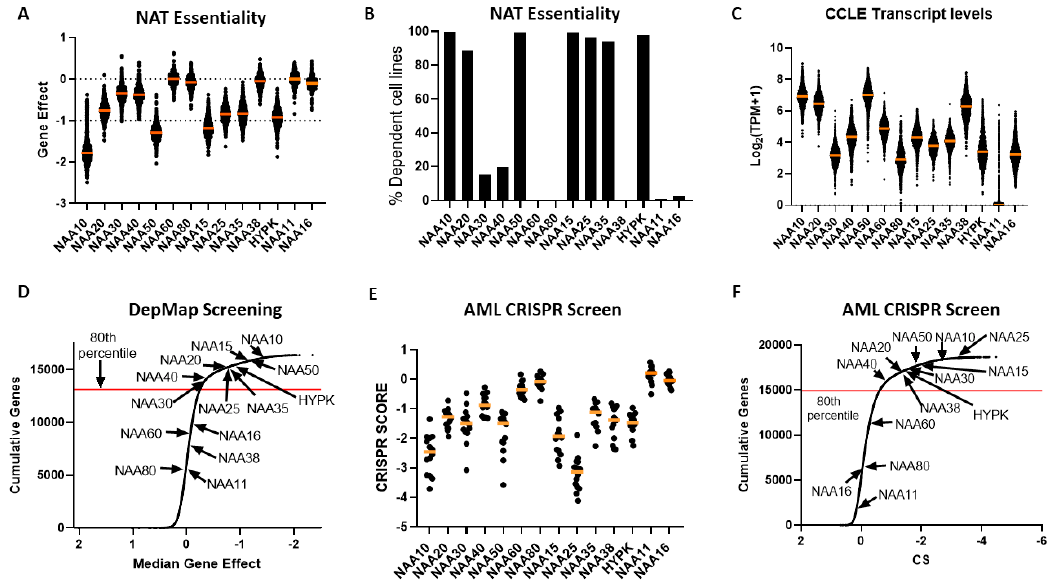
Figure 4. Dependency of cancer cells on functional NAT complexes. ( A ) Gene effect (CEREC) of CRISPR-CAS KO of human NAT catalytic and auxiliary genes across 739 cell lines. More negative values indicate greater sensitivity to KO. Each cell line is represented by a circle symbol, and the median gene effect across all cell lines is depicted by an orange line; ( B ) Percentage of cell lines with CRISPR-CAS KO data which were deemed as dependent on NAT gene, as calculated in DepMap database; ( C ) Transcript levels for NAT genes across CCLE study. The orange line represents the median of transcript level across the CCLE panel; ( D ) Cumulative frequency for median gene effect for all examined genes in DepMap CRISPR-CAS KO dataset. Arrows indicate the position of NAT catalytic subunits on this curve; ( E ) Scatterplot of CRISPR scores for NAT catalytic genes in study of 14 Acute Myeloid Leukaemia (AML) cell lines. Each circle symbolises a cell line and orange line depicts median CRISPR score. Lower CRISPR scores indicate greater sensitivity to KO; ( F ) Cumulative frequency for median gene effect for all examined genes in AML CRISPR KO dataset. Arrows indicate the position of NAT catalytic subunits on this curve.